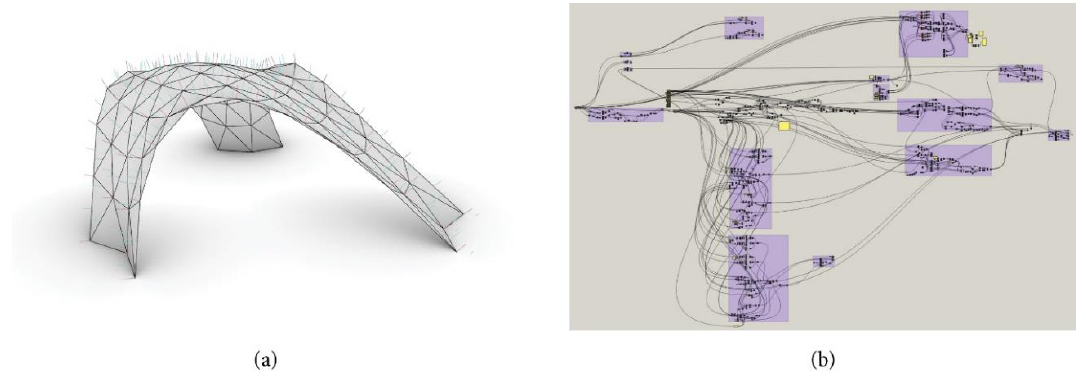
Figure 10. ( a ) Input geometry as basis for automated node design; ( b ) canvas of scripting interface.